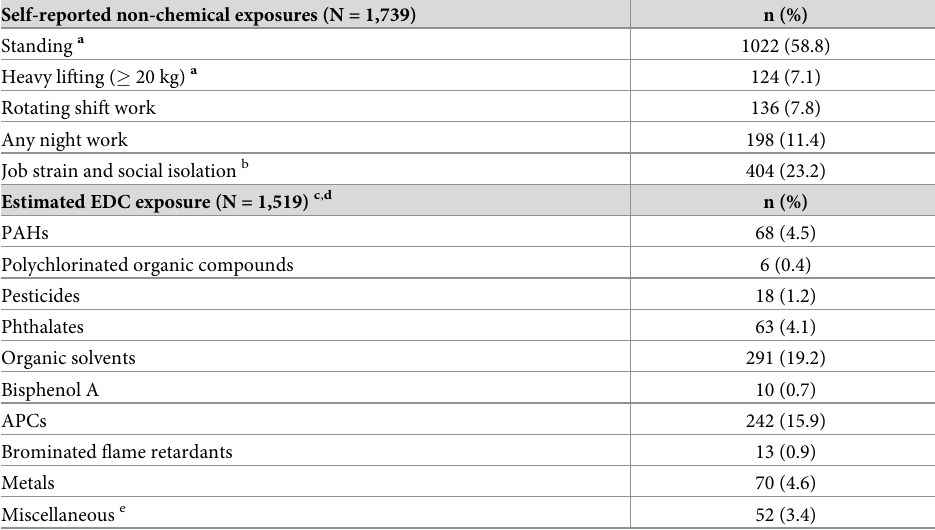
Table 2. Prevalence [ n (%)] of self-reported non-chemical occupational exposures and estimated exposure to endocrine disrupting chemicals during pregnancy, INMA, 2003-2008. Self-reported non-chemical exposures (N = 1,739) n (%) Standing a 1022 (58.8) Heavy lifting ( � 20 kg) a 124 (7.1) Rotating shift work 136 (7.8) Any night work 198 (11.4) Job strain and social isolation b 404 (23.2)